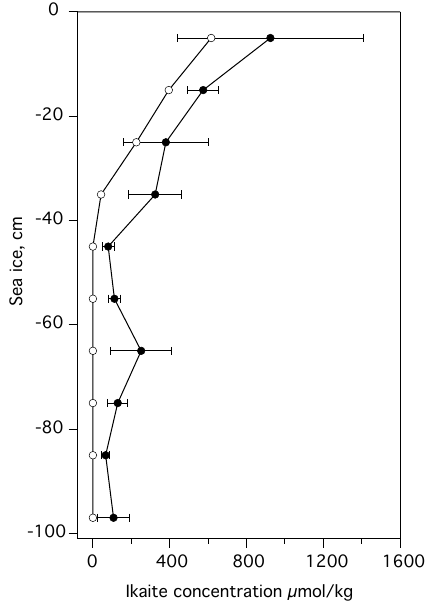
Fig. 9. Vertical profiles of ikaite concentration. Measured (- • -) and FREZCHEM calculated (-o-) at ICE